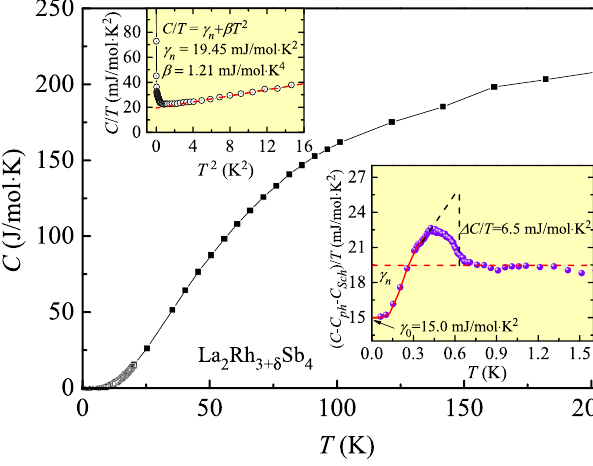
Figure 5. Temperature dependence of DC magnetic susceptibility for field perpendicular to b . The insets present real ( χ ′ ) and imaginary ( χ ′′ ) parts of AC susceptibility as functions of T , measured at various frequencies.